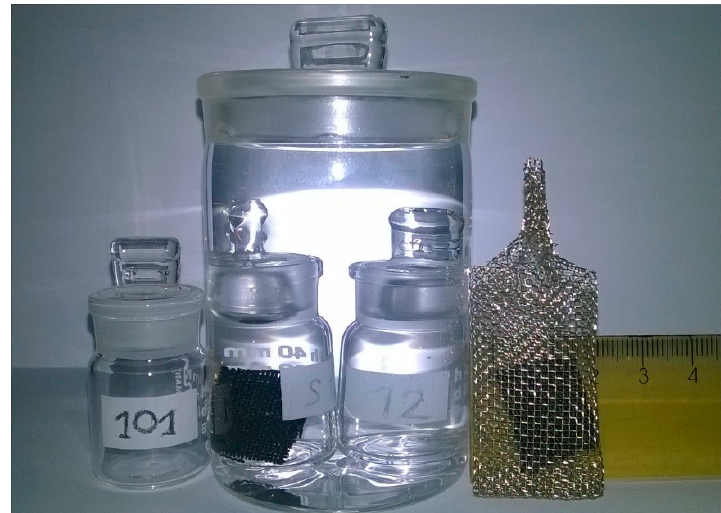
Figure 1. Weighing bottles filled with UPW for the transport of passive samplers and stainless steel casing with ACFs.